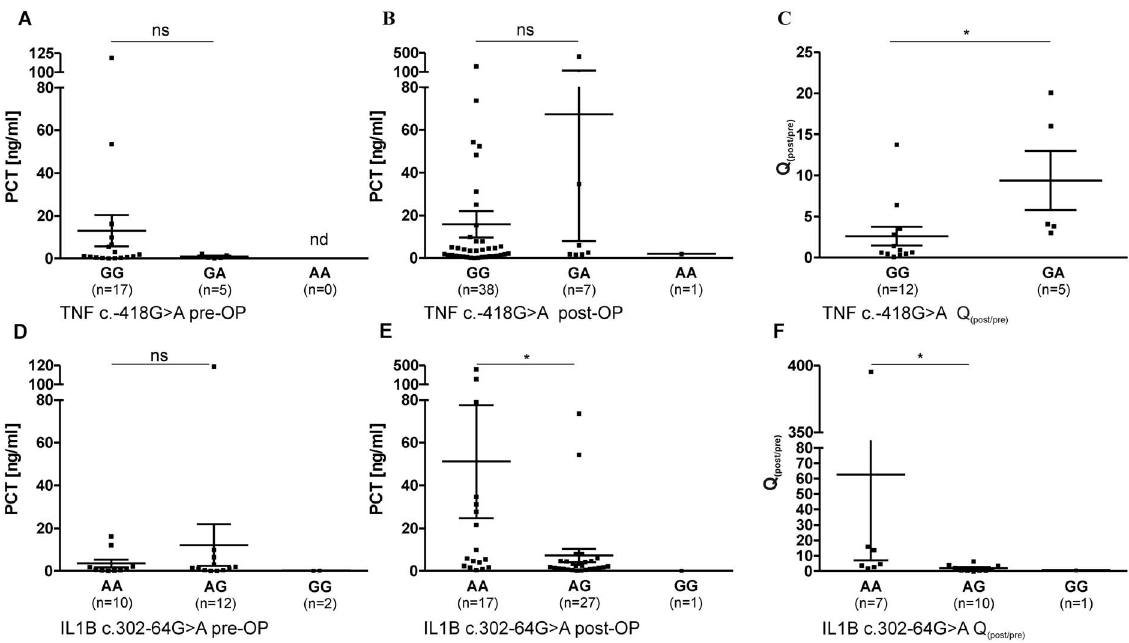
Figure 3. Pre- and postoperative PCT levels (mean ± SEM), as well as factorial change Q (post/pre) of PCT in the course of surgical intervention in patient sera (ns: not significant; nd: not determined, *=P , 0.05). 3A–C: PCT levels in correlation with TNF c.-418G . A; A: Preoperative PCT level, B: Postoperative PCT level, C: Q (post/pre) of PCT in the course of surgical intervention; 3E–G: PCT levels in correlation with IL1B c.302-64G . A; A: Preoperative PCT level, B: Postoperative PCT level, C: Q (post/pre) of PCT in the course of surgical operative intervention.